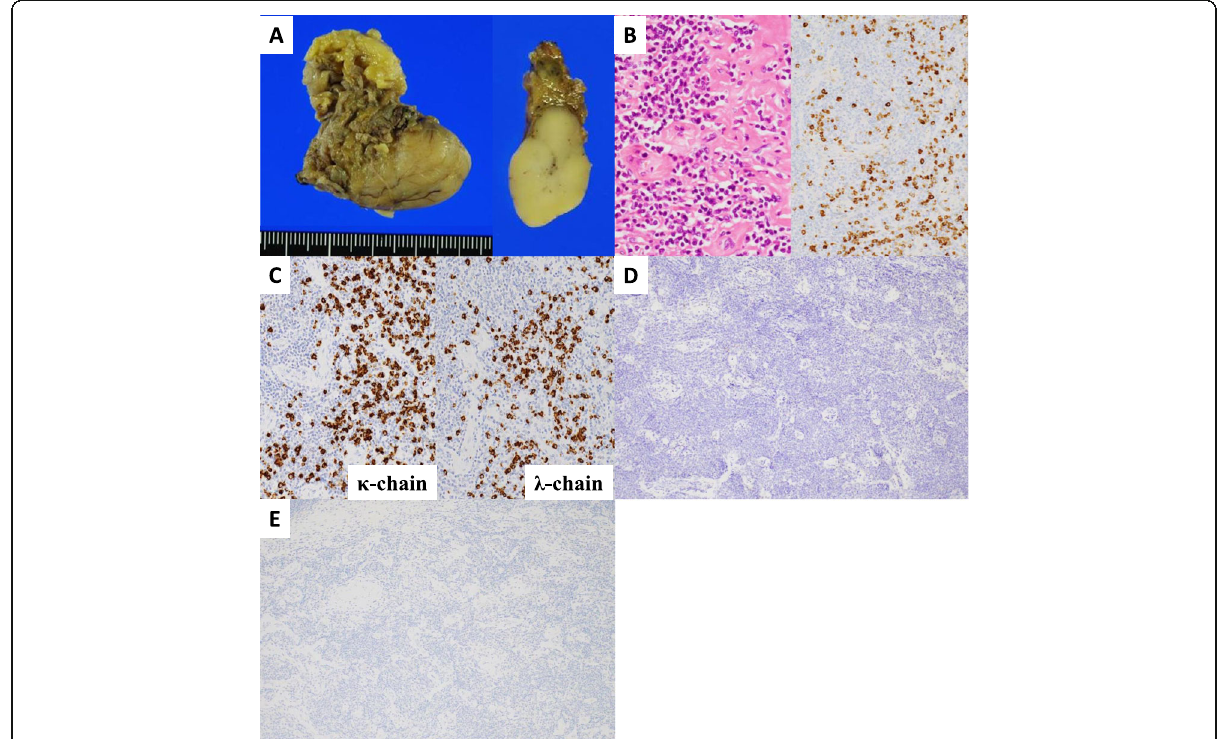
Fig. 2 Pathological findings. A macroscopic view of the resected tumor, which is a lobulated, well-defined, white solid mass with one section ( a ). Histopathological findings of the specimen showed dense lymphoplasmacytic infiltration with sclerotic stroma (hematoxylin and eosin staining, 400×), and over 50% of IgG4/IgG-positive plasma cells (immunostaining, 200×) ( b ). No deviation in kappa chain- and lambda chain-positive plasma cells was noted ( c , 200×), and neither keratin-positive thymocytes ( d , 40×) nor terminal deoxynucleotidyl transferase-positive lymphocytes ( e , 40×) were observed (immunohistochemical